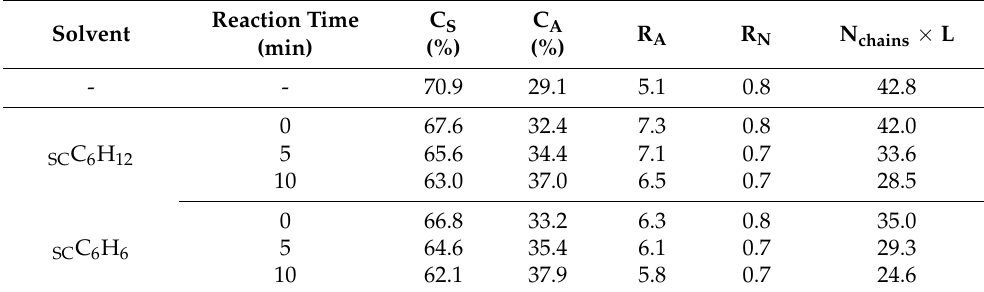
Table 4. Average molecular structure parameters of liquid visbreaking products obtained in SC C 6 H 6 or SC C 6 H 12 . Temperature of 380 ◦ C, solvent-to-heavy-oil ratio of 3:1 (wt), and solvent density of 0.25